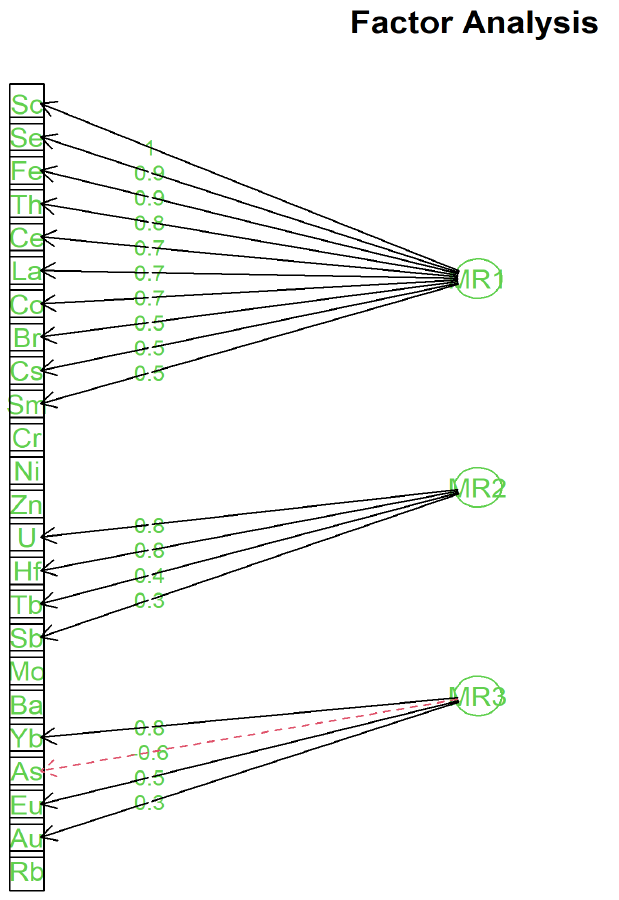
Figure 8. The exploratory factor analysis of samples of elemental exposure to PM10 divided based on the factor loadings. All variables were analyzed as mass fractions (μg/kg). Table 3. The factor loadings based on the correlation matrix.